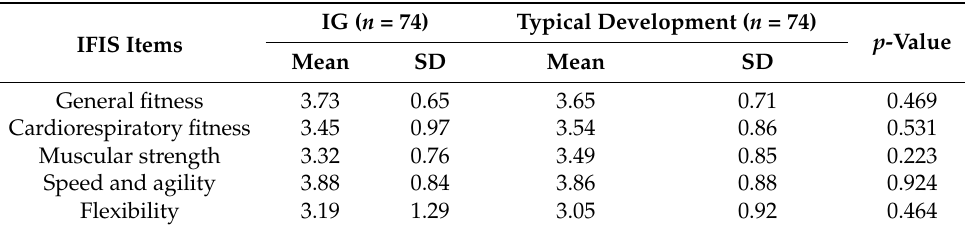
Table 3. Comparison between intellectually gifted and typical development groups using Student’s t -test.